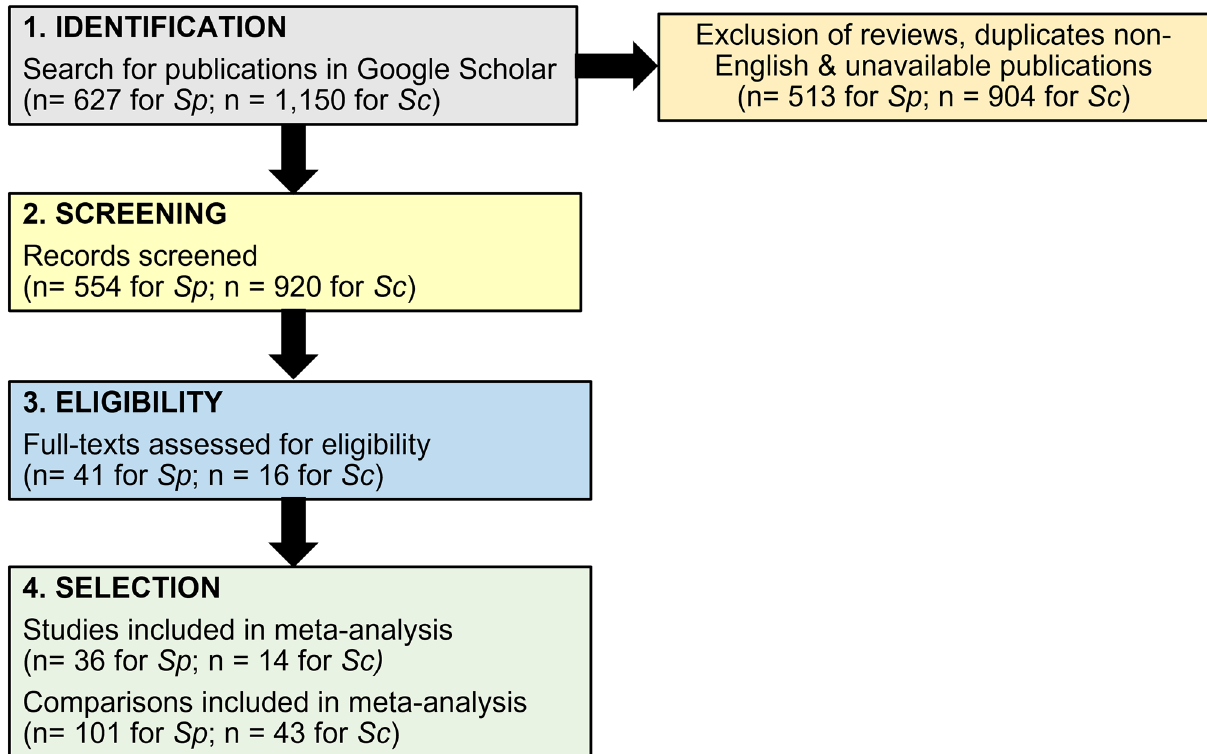
Figure 1. PRISMA workflow used to select publications for inclusion in the meta- analysis of nutritional benefits of microalgae in fish. Sp Spirulina dataset, Sc Schizochytrium